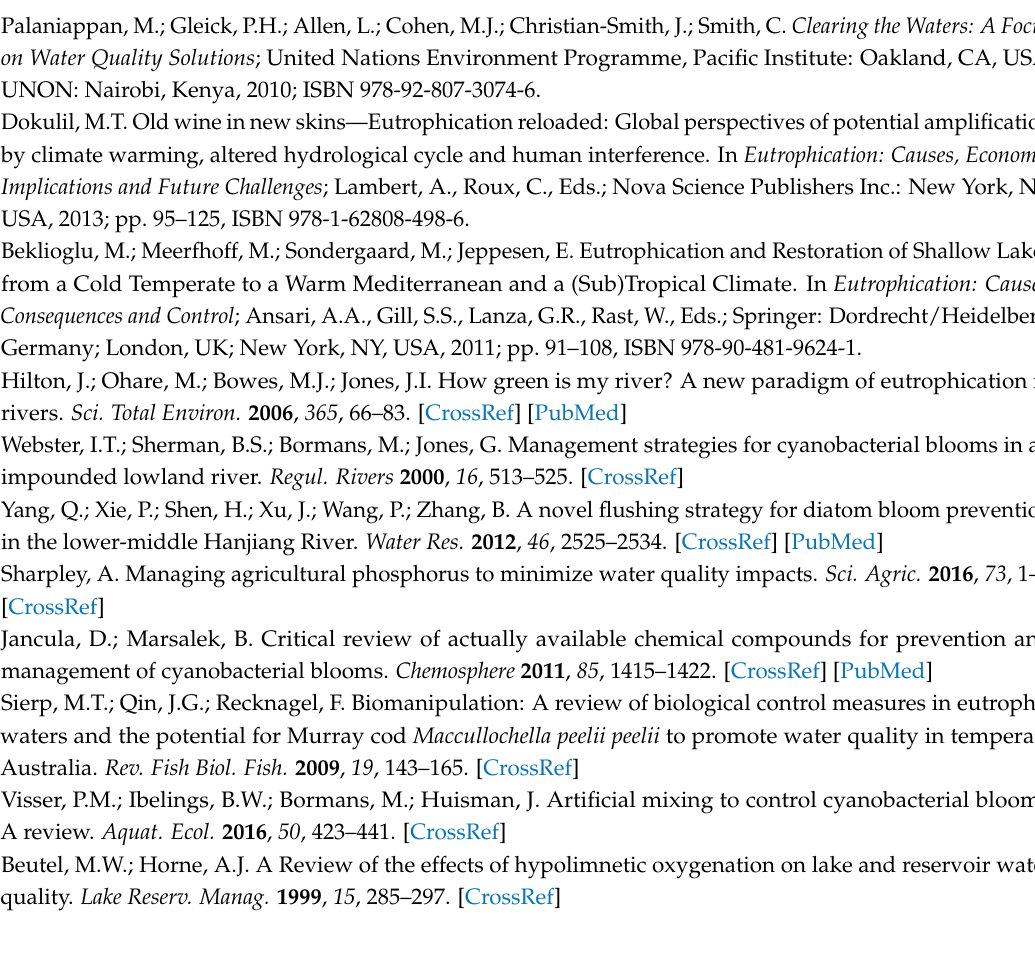
Figure S1: Immediate and long-term effect of 15 min sonication on the (a) ammonia-nitrogen, and (b) soluble reactive phosphate (SRP) values of the outbreak and caution level